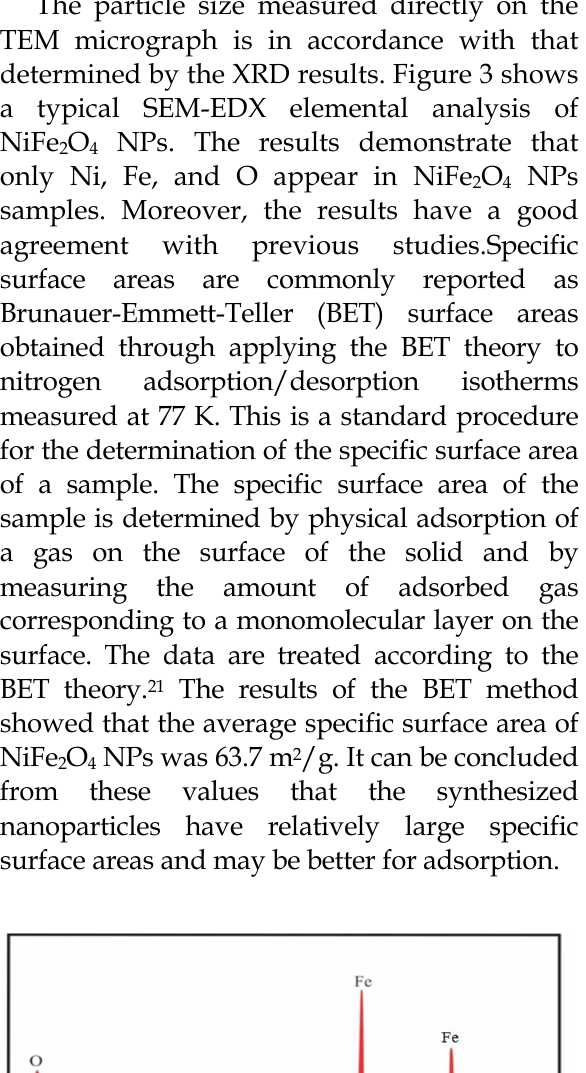
O nanoparticles 2 4